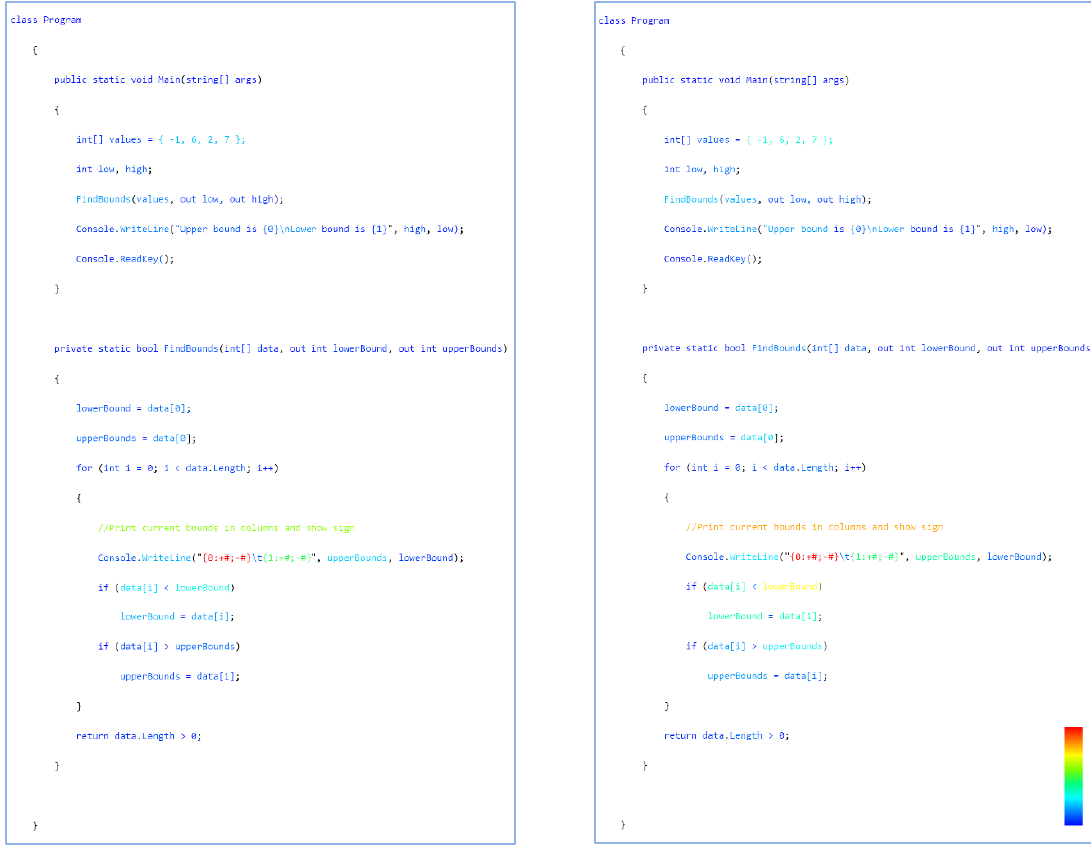
Figure 5. Heatmaps of second snippet for (a) black-and-white code on the left and (b) colour code on the right